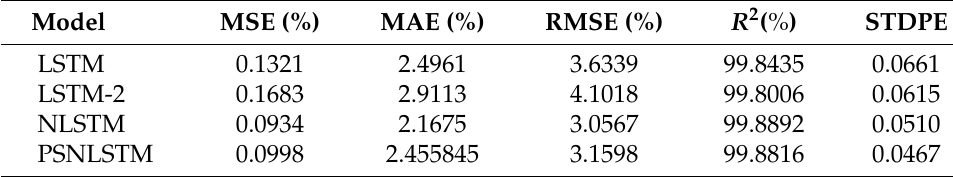
Table 4. The temperature prediction performance of ϑ ST .